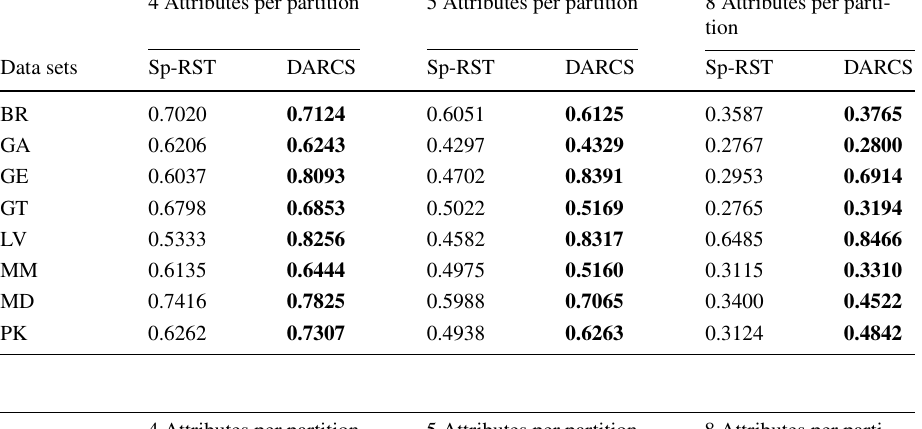
Table 8 Execution time comparison(unit: